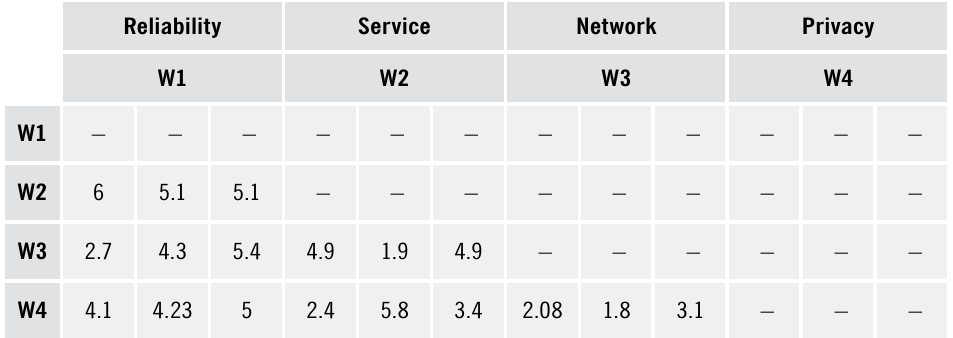
Table 2. Paired comparison matrix of security criteria in the IoT supply chain, based on experts’